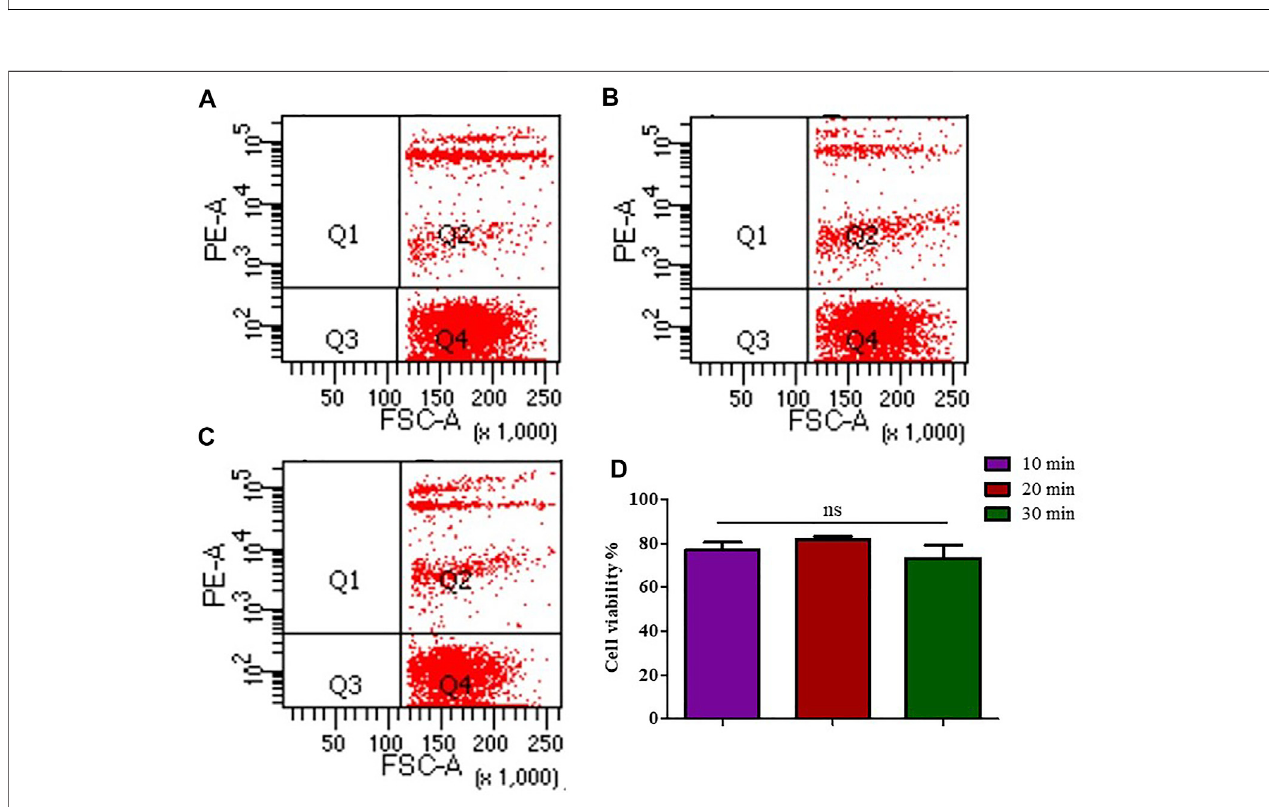
FIGURE 2 | The effect of FCMase enzyme digestion time durations on cell viability during the preparation of single cell suspension. (A) 10 min, (B) 20 min, (C) 30 min,ofFCMaseenzymedigestionduration. (D) StatisticalcomparisonoftheeffectofFCMaseenzymedigestiontimedurationsoncellviability.Dataarepresentedas means ± SD; ns p value =